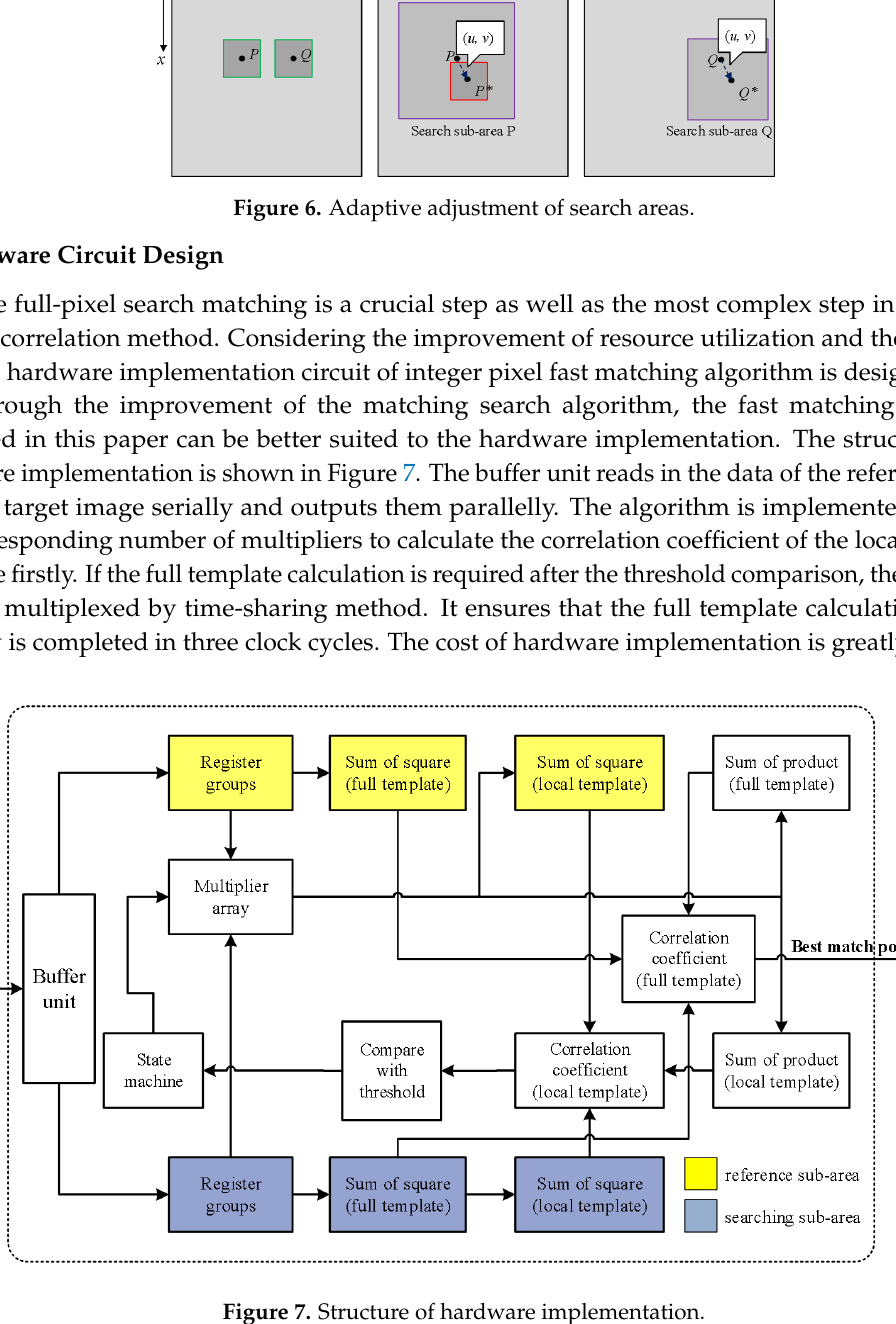
Figure 7. Structure of hardware